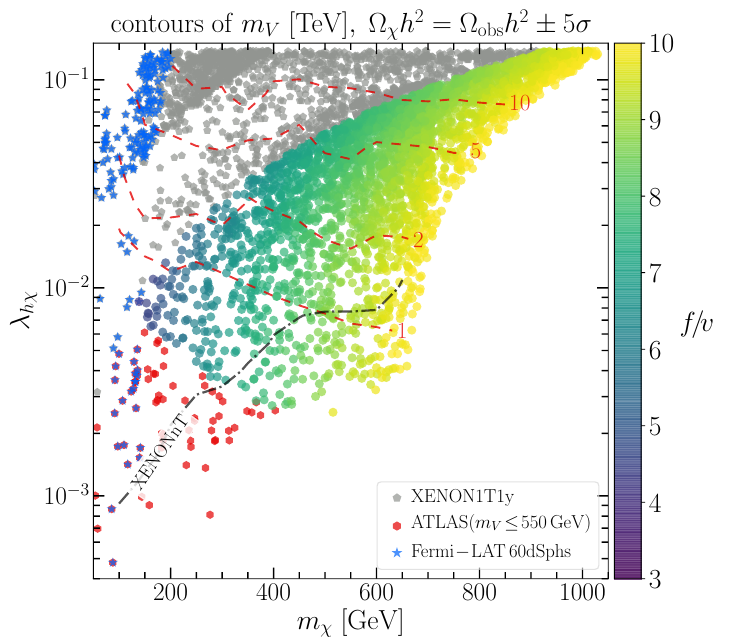
Figure 14 . A parameter scan with all points producing the correct relic abundance in the m (cid:31) vs (cid:21) h(cid:31) . The colored (gray hexagon) points allowed (excluded) by the XENON1T1y direct detection experiment. The allowed points are color coded for di(cid:11)erent f=v values. The red (pentagon) points are excluded by the ATLAS search of quirky states with m V . 550 GeV, while the indirect detection projected 95% C.L. sensitive points due to Fermi-LAT with 15 years and 60 dSPhs are marked as blue (stars). The dashed (red) contours represent di(cid:11)erent values of m V [TeV], whereas the dash-dotted (black) curve gives the projected sensitivity of